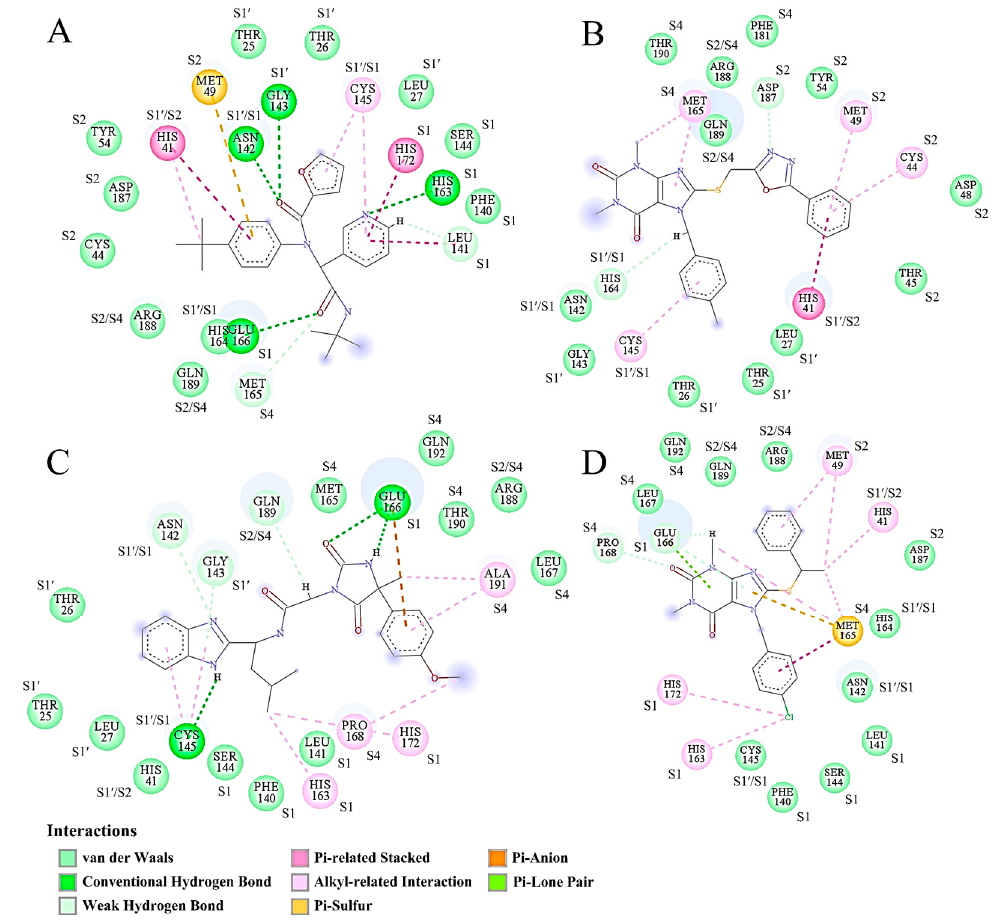
Figure 8. Binding modes of the representative structures of the four Mpro-inhibitor complexes. The binding mode is shown by the 2D interaction diagram of ML188 ( A ), ECI2 ( B ), ECI3 ( C ), and ECI4 ( D ) with Mpro residues. Dashed lines with different colors represent different interaction types other than vdW contacts. Each circle with the same size represents an Mpro residue and is colored according to the main interaction type involved. The size of the light-gray circle surrounding the residue circle varies proportionally to the amount of the buried surface area upon binding. The pocket label beside each Mpro residue indicates which pocket(s) the residue belongs to. The residue with a double label (e.g., S1 (cid:48) /S1) indicates that it participates in the formation of two different pockets or borders between the two